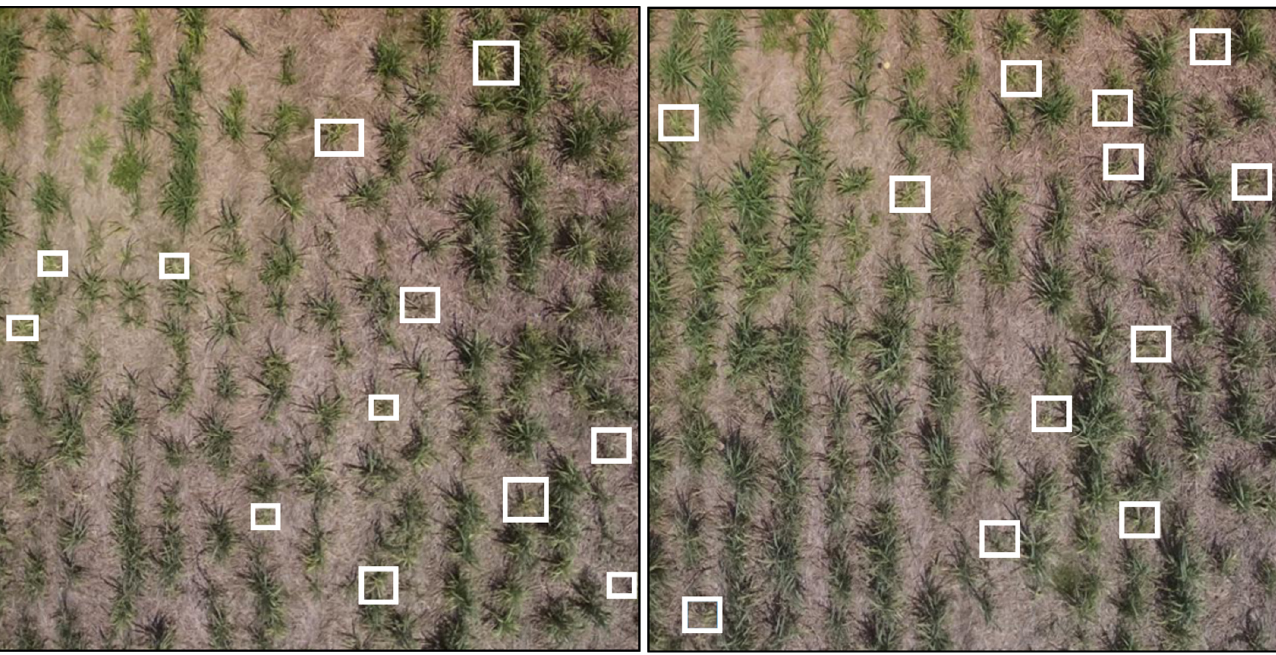
Figure 14. Ground truth bounding boxes.